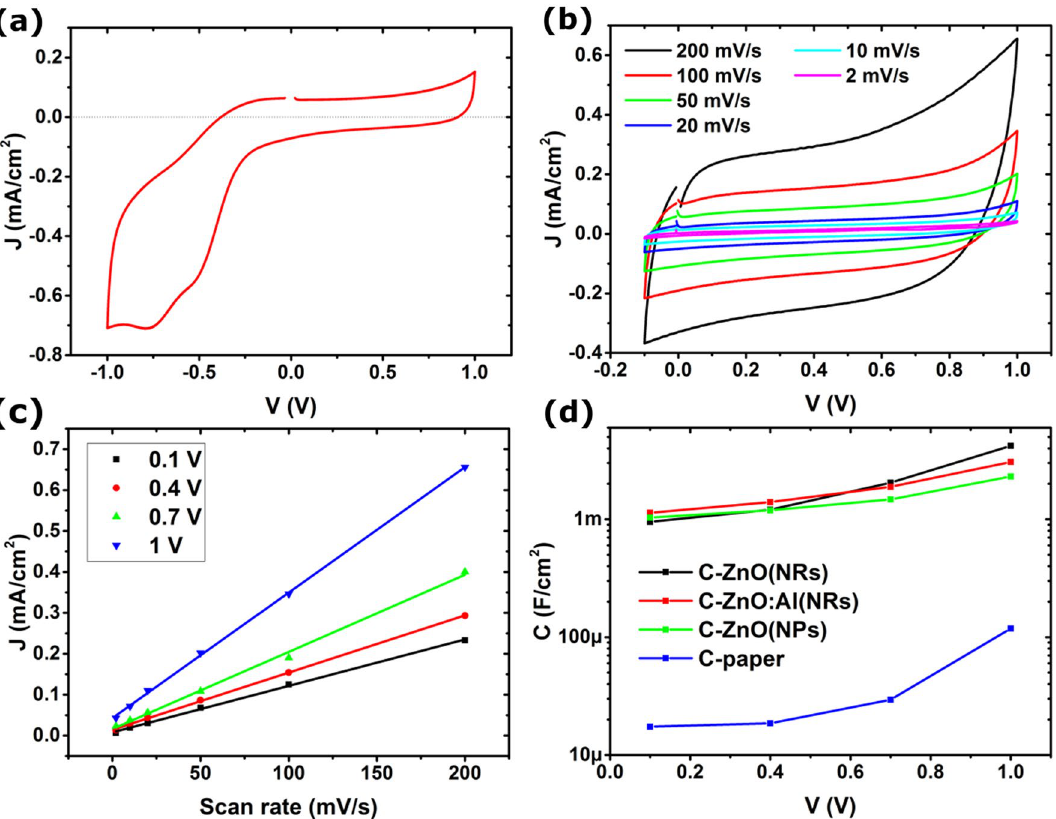
Figure 4. Cyclic voltammograms of a C-ZnO(NRs) electrode at ( a ) a scan rate of 50 mVs −1 and ( b ) different scan rates. ( c ) Current density versus scan rate, extracted from ( b ) and Fig. S3 at four different electrode potentials. ( d ) Calculated differential areal capacitance versus potential for all four investigated CDI nanocomposite electrodes immersed in the same 20 mM NaCl